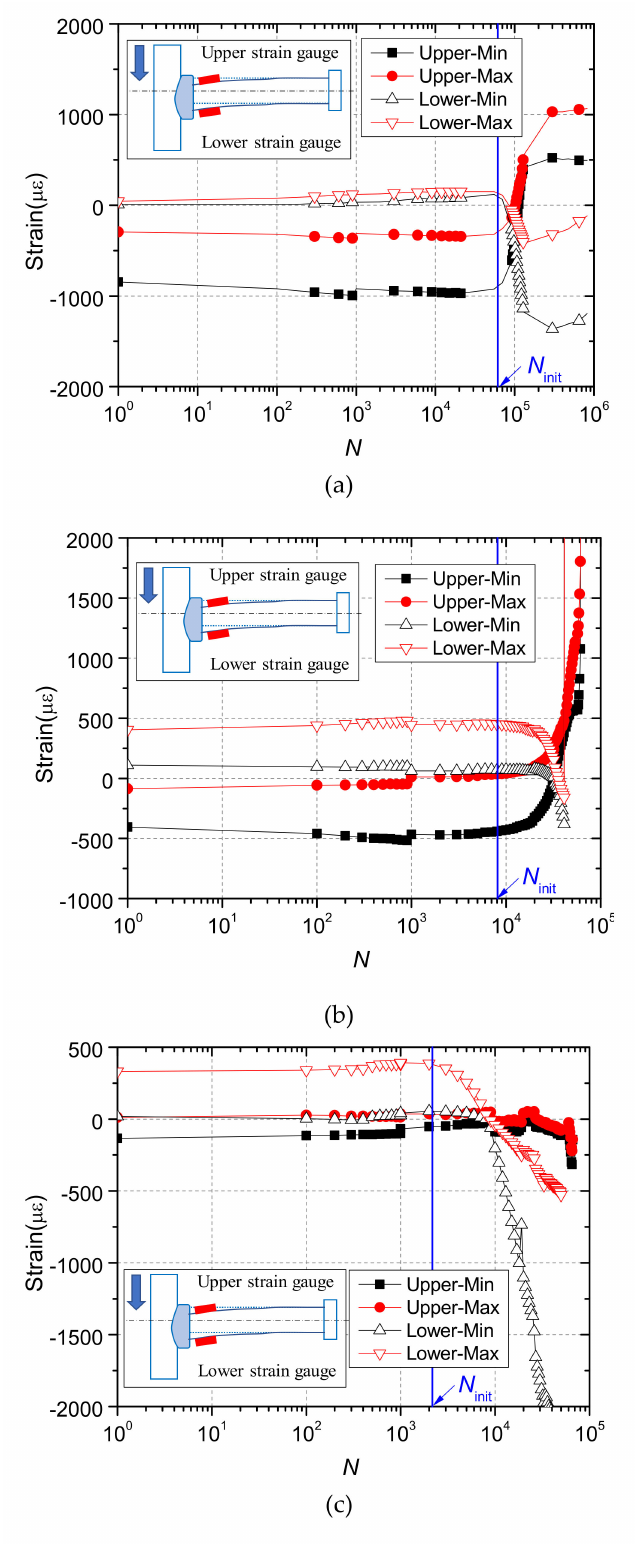
Figure 16. Results of strain gauges: ( a ) RS25-50-U; ( b ) RS25-70-U; ( c )